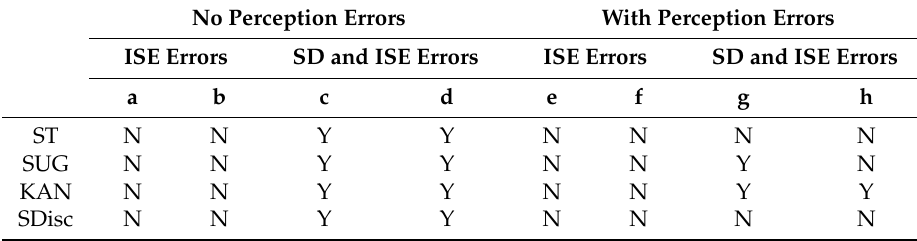
Table 9. Summary: Are Shunners evolutionary stable in the linked-game? No Perception Errors With Perception Errors ISE Errors SD and ISE Errors ISE Errors SD and ISE Errors